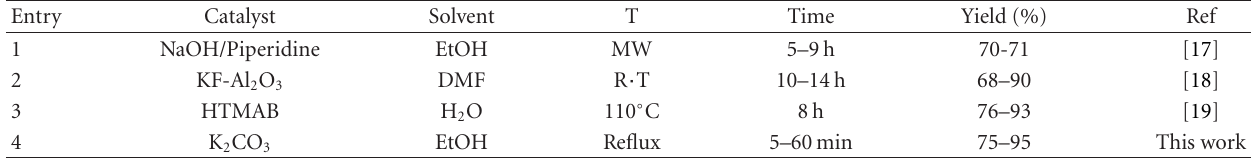
Table 2: Comparison of results using K 2 CO 3 with other catalyst for synthesis of 2-amino-4 H